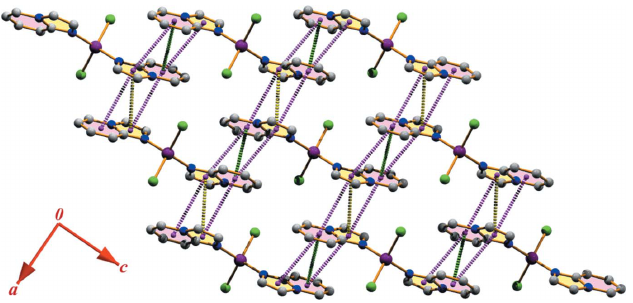
Figure 3 Monomeric units linked through multi (cid:3) – (cid:3) stacking interactions leading to the formation of a supramolecular layered assembly. Color codes: the green and yellow dotted lines denote (cid:3) – (cid:3) stacking interactions between two pyridine rings and two imidazo rings, respectively, whereas (cid:3) – (cid:3) stacking interactions between pyridine and imidazo rings are represented by pink dotted lines.